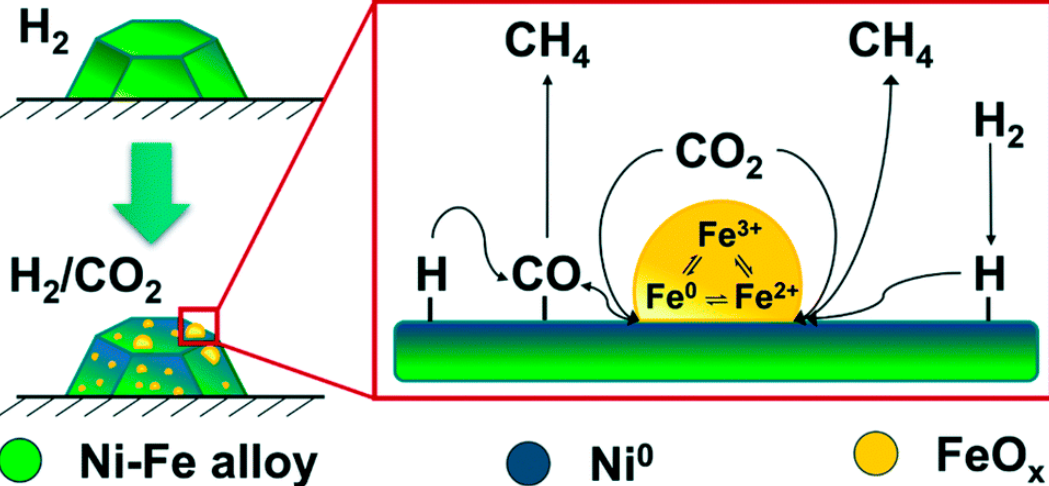
Figure 3. Scheme of the CO 2 activation mechanism on Ni–Fe alloy-based catalysts during methanation reaction under realistic conditions. Reproduced with permission from [49]. Copyright: Royal Society of Chemistry, London, UK, 2020.